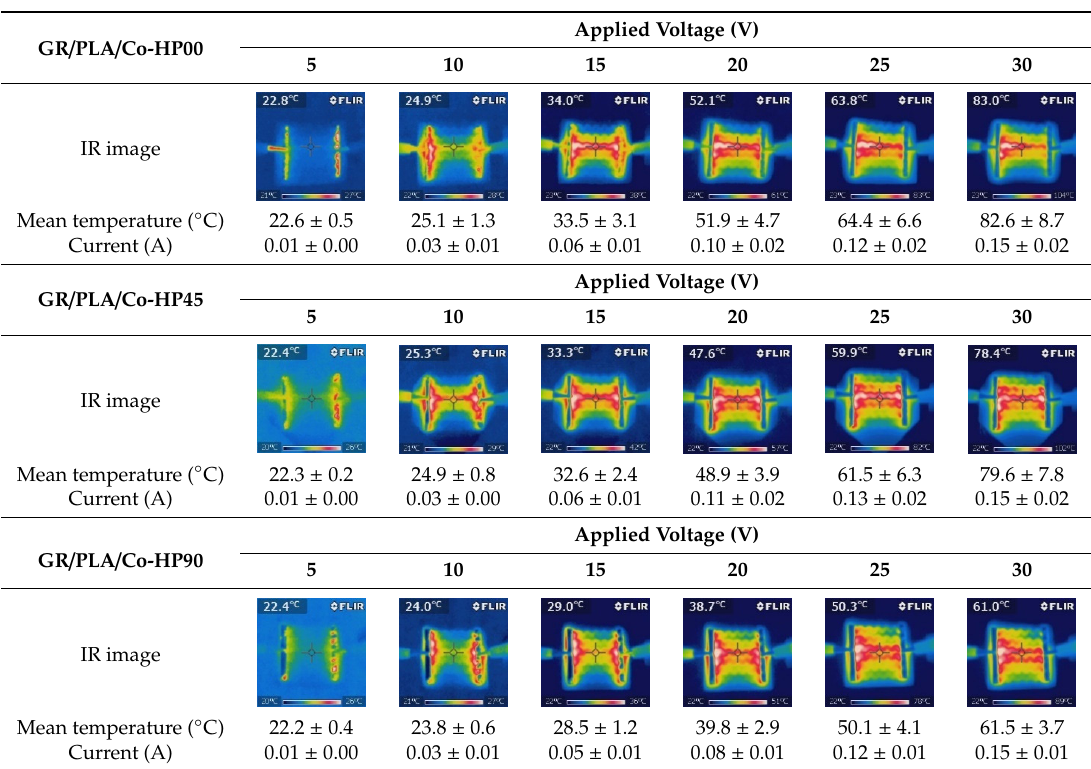
Table 8. IR images of GR/PLA CFDM 3D-printed horseshoe pattern cotton fabric with different 3D printing directions.